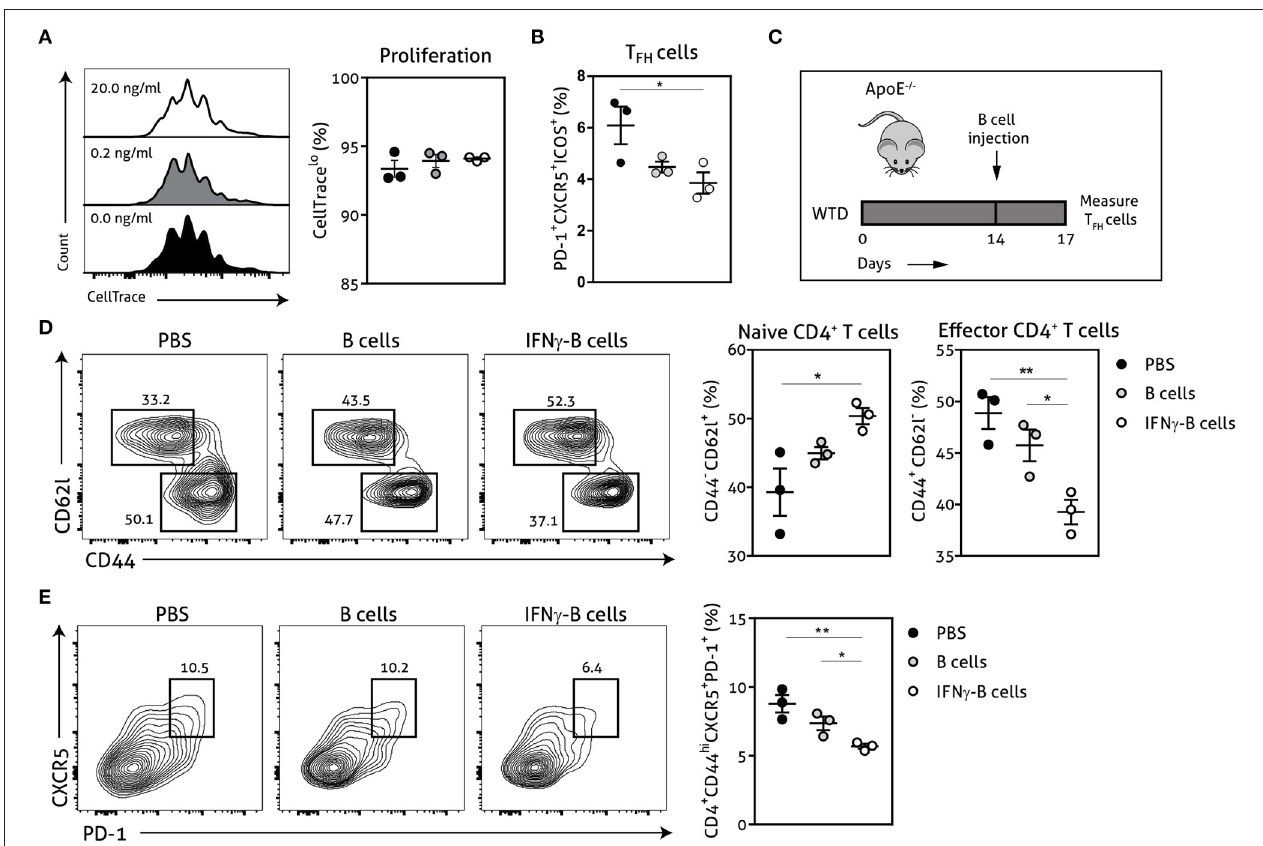
FIGURE 2 | IFN γ -B cells inhibit T follicular helper cells in vitro and in vivo. Isolated CD19 + B cells were unstimulated or stimulated with 0.2ng/ml or 20.0ng/ml IFN γ for 24h and co-cultured with isolated CD4 + T cells. The coculture was stimulated with anti-CD3 (5 µ g/ml) for 72h after which (A) proliferation of CD4 + T cells was analyzed with CellTrace Violet and (B) the number of follicular CD4 + T helper (T FH ) cells were analyzed. (C) apoE − / − mice were fed a Western type diet for 2 weeks after which they either received PBS, freshly isolated CD19 + B cells (B cells) or CD19 + B cells stimulated with 20.0ng/ml IFN γ for 24h (IFN γ -B cells). After three days, mice were sacrificed and spleens were isolated for flow cytometry analysis for (D) naive (CD62l + CD44 − ) and effector (CD62l − CD44 hi ) CD4 + T cells and (E) T follicular helper cells (CD4 + CD44 hi CXCR5 + PD-1 + ). Representative flow charts of the CD4 + T cell population are shown. Data are analyzed with a One-Way ANOVA and shown as mean ± SEM (* p < 0.05, ** p < 0.01). n =